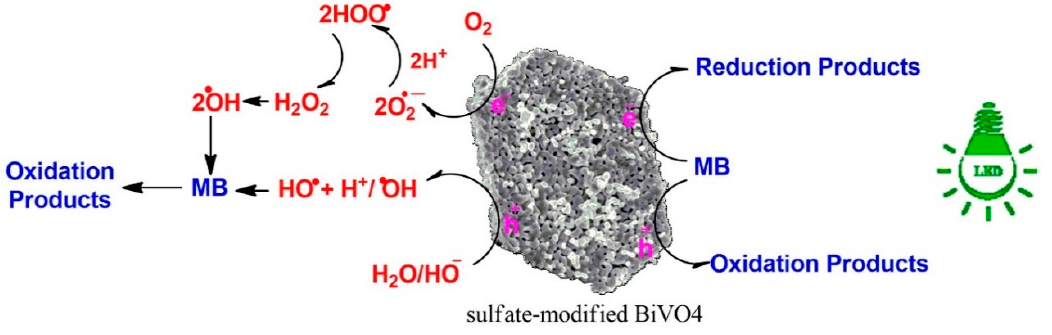
Figure 10. Illustrative representation of direct mechanism for MB photodegradation process.